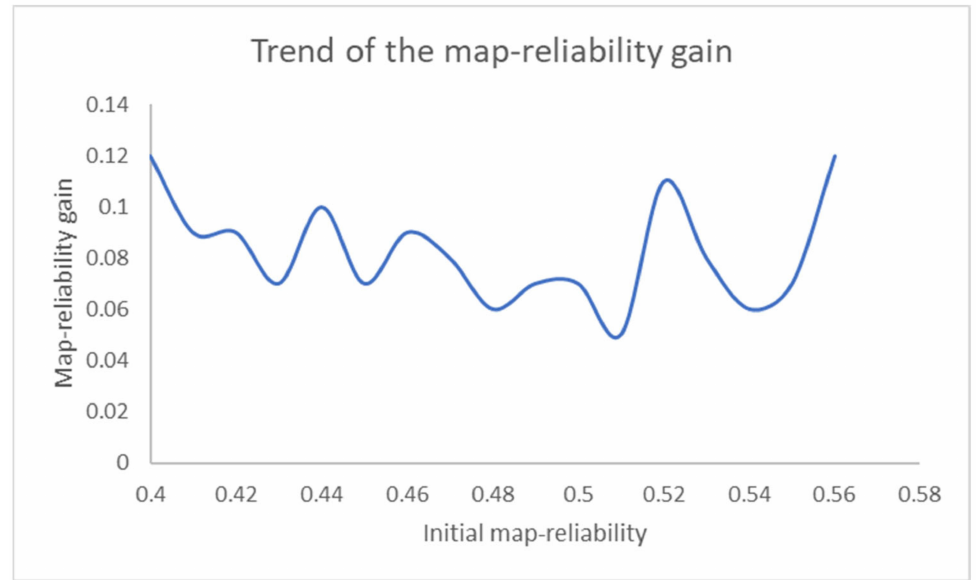
Figure 18. Trend of the map-reliability gain.